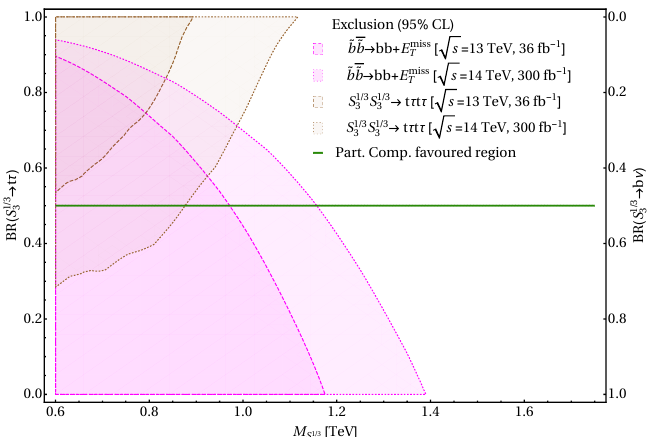
Figure 3. Bounds on the S 1 = 3 leptoquark branching ratios into t(cid:28) and b(cid:23) (assuming a negligible 3 t(cid:22) branching ratio) as a function of leptoquark mass M . The current bounds (dashed line) and S 1 = 3 3 projected bounds (dotted line) for the LHC Run 3 derived from the t (cid:22) t(cid:28) + (cid:28) (cid:0) and b (cid:22) b + E miss T